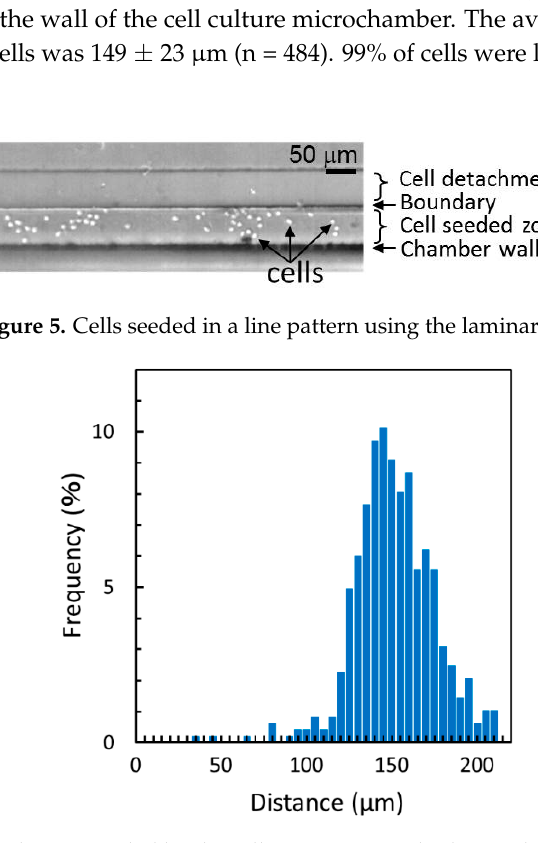
Figure 6. Cellular distribution seeded by the cell patterning method using laminar flow. The distance is the length between the edge of the cell detachment zone and each seeded cell.